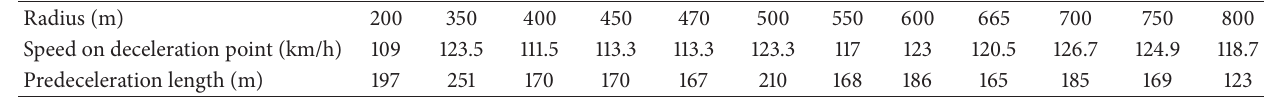
Table 1: Testing results when vehicles are driving along SHCs.